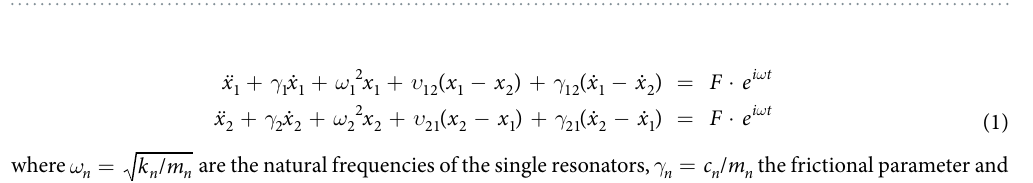
Figure 4. Simulation of Fano resonances in coupled resonators. ( a ) Comparison of the vibration spectra of the two cantilevers with physical dimension of MC_9 resonators in a weakly coupled array. Solid lines represent the numerical calculation, while the dotted lines are the experimental data. ( b ) Schematic model of the coupled cantilever array. ( c ) 3-D visualization of the device experimental amplitude at the second resonance frequency of the first